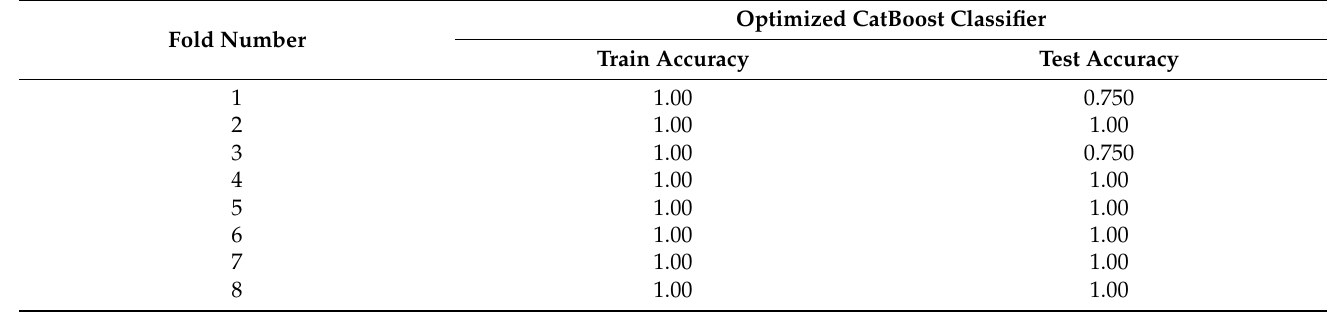
Figure 5. Accuracy curve obtained using the hybrid model with optimized XGBoost classifier. Table 5. Training vs. testing performance of optimized Catboost with 8-fold